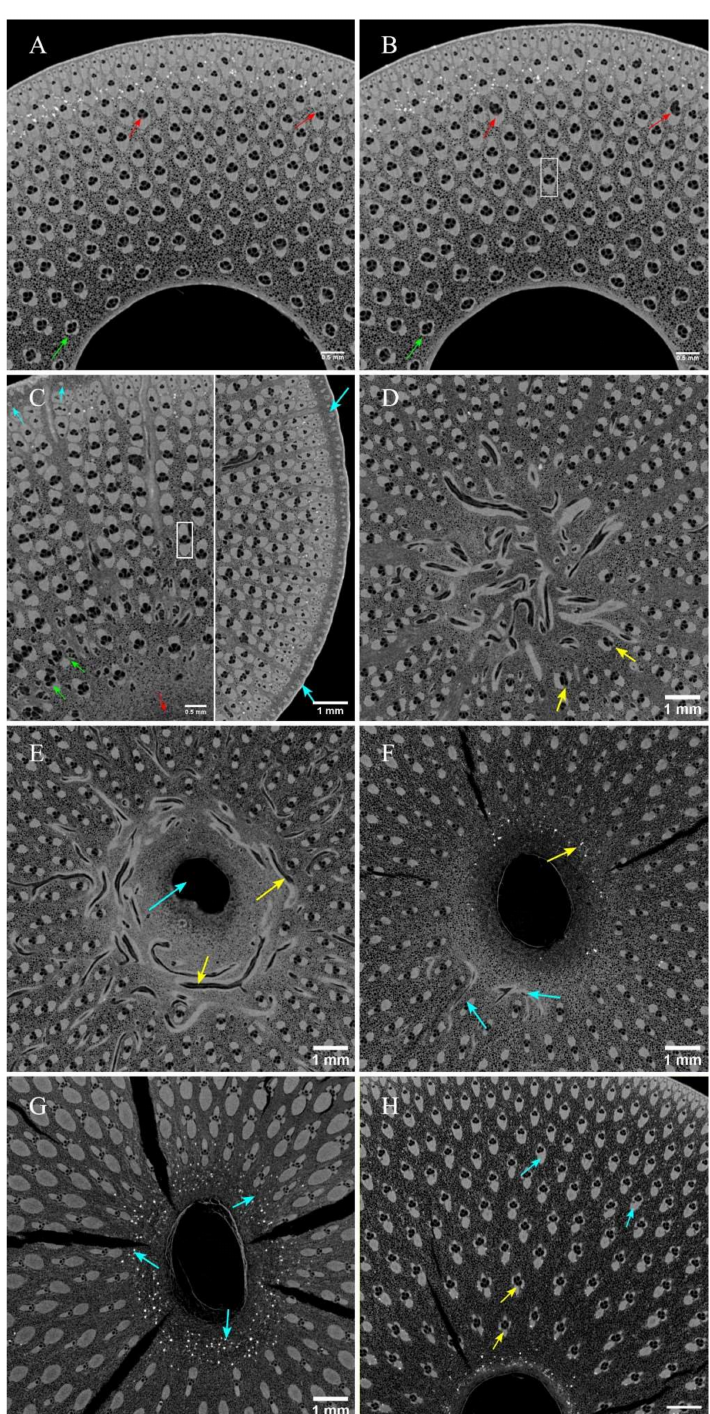
Figure 5. Specific picture of the cross-section of the bamboo node. Pictures ( A – H ) show partially enlarged illustrations of Pictures ( a1 – h1 ), respectively (picture ( B , C ), the size of the white wireframes of Pictures ( B , C ) was 0.35 × 0.8 mm 2 ). ( A , B ) Semi-open type vascular bundle (green arrow); con- ducting tissue before and after enlarged and deformed (red arrow). ( C ) Diaphragm (red arrow), irregularly shaped conducting tissue (green arrow), vascular bundles in the cortex (blue arrow). ( D ) Axial vascular bundles which changed orientation (yellow arrow). ( E ) Medullary cavity (blue arrow), transverse tubules (yellow arrow). ( F ) High-density materials (yellow arrow), transverse vascular bundle almost disappeared (blue arrow). ( G ) A large amount of high-density material (blue arrow). ( H ) Semi-open type vascular bundle (blue arrow), open type vascular bundle (yellow